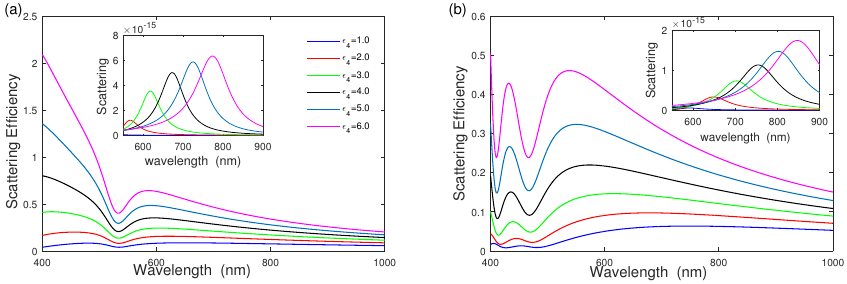
Figure 6. The effect of surrounding medium dielectric function ε 4 on scattering efficiency and scattering. ( a ) Silver–dielectric–gold nanoshell with ε 2 = 2.0, ( b ) gold–dielectric–silver nanoshell with ε 2 = 2.0,